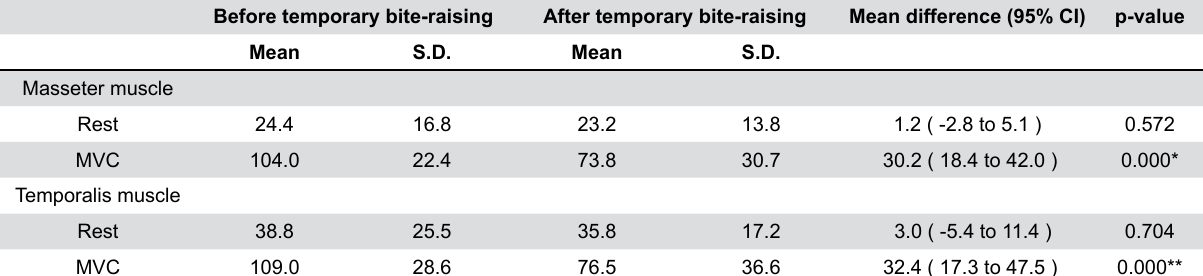
Table 2- Normalized electromiography (EMG) activity (%) during rest and MVC before and after temporary bite-raising